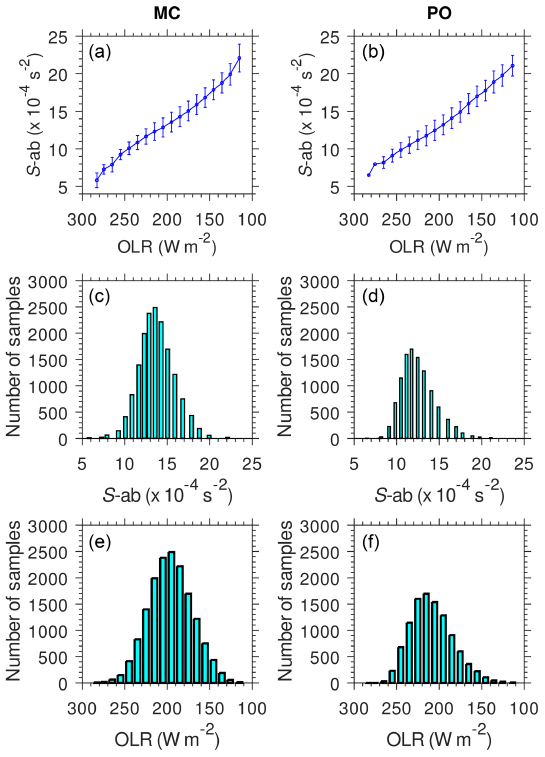
Figure 14. Diagram of S -ab versus OLR (a, b) , and of the number of samples for S -ab and OLR ( c , d and e , f , respectively) in the MC (a, c, e) and PO (b, d, f)